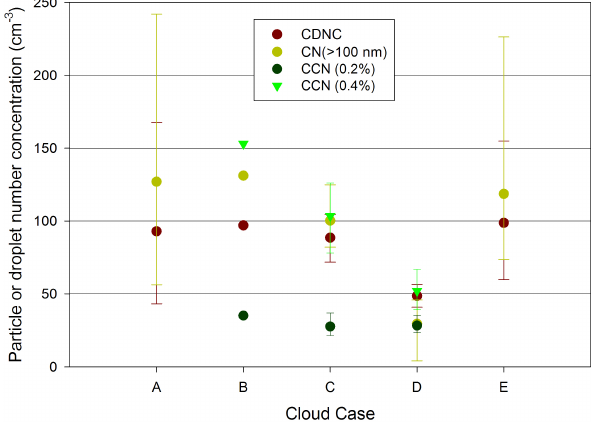
Fig. 5. Measured versus calculated CCN concentrations. A 1:1 line is added as a guide to the